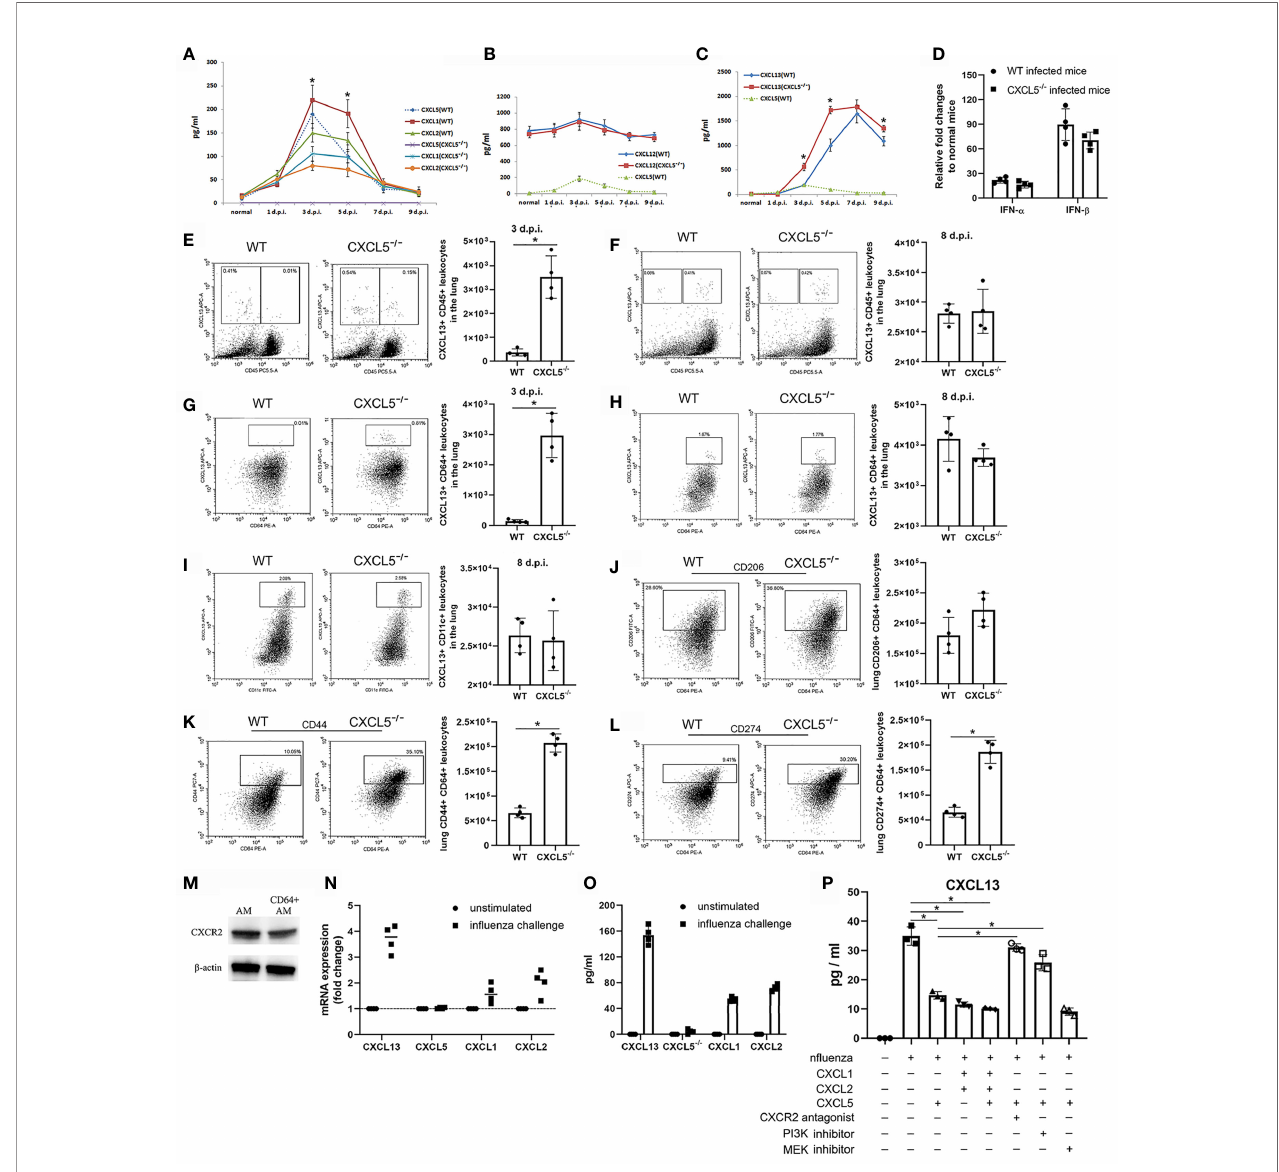
FIGURE 6 | CXCL5 regulated CXCL13 expression in pulmonary CD64+ macrophages/monocytes via the CXCL1/2/5-CXCR2 signaling pathway. (A – C) The protein levels of CXCL1/2 (A) , CXCL12 (B) , and CXCL13 (C) in the BALF of infected mice were measured by ELISA, and the level of CXCL5 was used as a reference (n=5). (D) RT-qPCR for IFN- a and IFN- b mRNA was performed in lung homogenates from WT and CXCL5 -/- mice before and after (3 d.p.i.) in fl uenza infection. The fold changes in the mRNA expression levels of these genes were calculated using the 2 - DD Ct method of relative quanti fi cation with GAPDH as the endogenous reference gene. The relative fold changes in IFN- a and IFN- b expression in infected mice compared to normal mice are presented (n=4). (E, F) Percentages and numbers of CXCL13-expressing cells among single lung cells from WT and CXCL5 -/- mice at 3 d.p.i. (E) and 8 d.p.i. (F) as assessed by intracellular staining of CXCL13 protein (APC-CXCL13) and fl ow cytometry (n=4). (G, H) Percentages and numbers of CXCL13-expressing cells among pulmonary CD64+ cells from WT and CXCL5 -/- mice at 3 d.p.i. (G) and 8 d.p.i. (H) as assessed by intracellular staining of CXCL13 protein (APC-CXCL13) and fl ow cytometry (n=4). (I) Percentages and numbers of CXCL13-expressing cells among pulmonary CD11c+ cells from WT and CXCL5 -/- mice at 8 d.p.i. as assessed by intracellular staining of CXCL13 protein (APC- CXCL13) and fl ow cytometry (n=4). (J – L) Percentages and numbers of CD206 (J) , CD44 (K) , and CD274 (L) surface markers among pulmonary CD64+ cells from WT and CXCL5-/- mice at 3 d.p.i. (n=4). (M) Detection of the expression of mouse CXCR2 on total AMs and CD64+ AMs by western blotting. (N) RT-qPCR was performed on cell lysates of cultured CD64+ macrophages after 10 h of in fl uenza challenge or unstimulated (control) conditions, and the fold changes were calculated as described in the MATERIALS AND METHODS section (n=4). (O) Expression levels of the indicated chemokines from supernatants of cultured CD64+ macrophages after 20 h of in fl uenza challenge or unstimulated (control) conditions as determined by ELISA (n=4). (P) ELISA was used to determine the expression levels of CXCL13 protein in supernatants of cultured CD64+ macrophages after 20 h of in fl uenza challenge and treatment with the indicated recombinant chemokine proteins, the CXCR2 antagonist SB225002, the PI3K inhibitor LY294002, and the MEK inhibitor PD98059 (n=3). The error bars represent the SDs. *P < 0.05 based on Student ’ s t